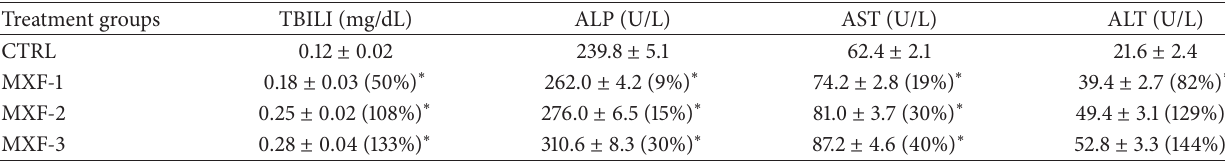
Table 2: Influence of MXF on plasma biomarkers of hepatotoxicity in rat. Treatment groups